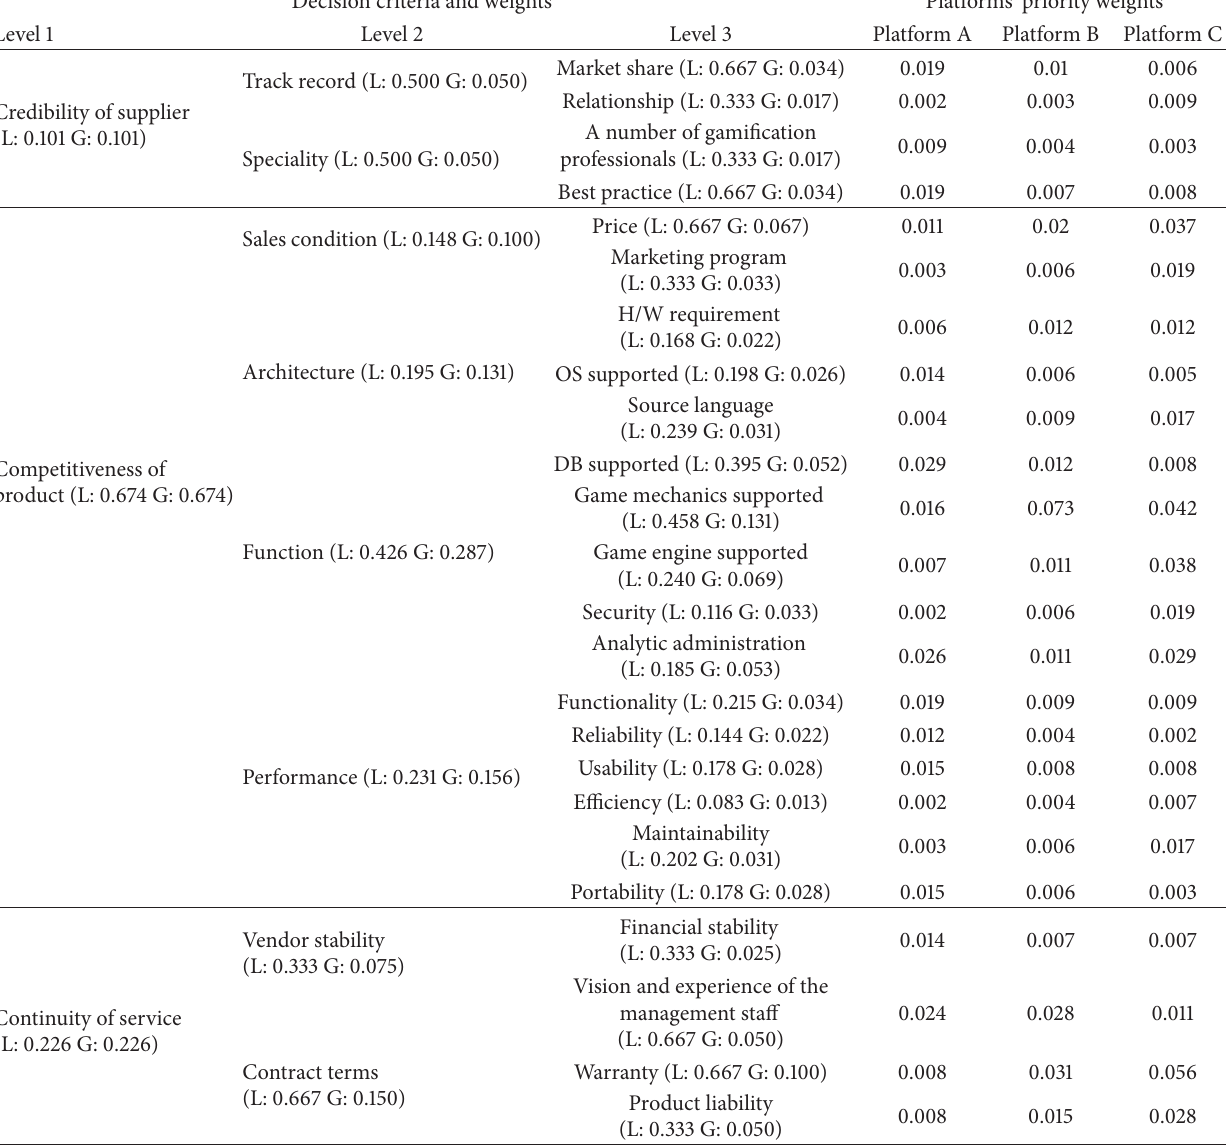
Table 4: Normalized priority weights of three gamification